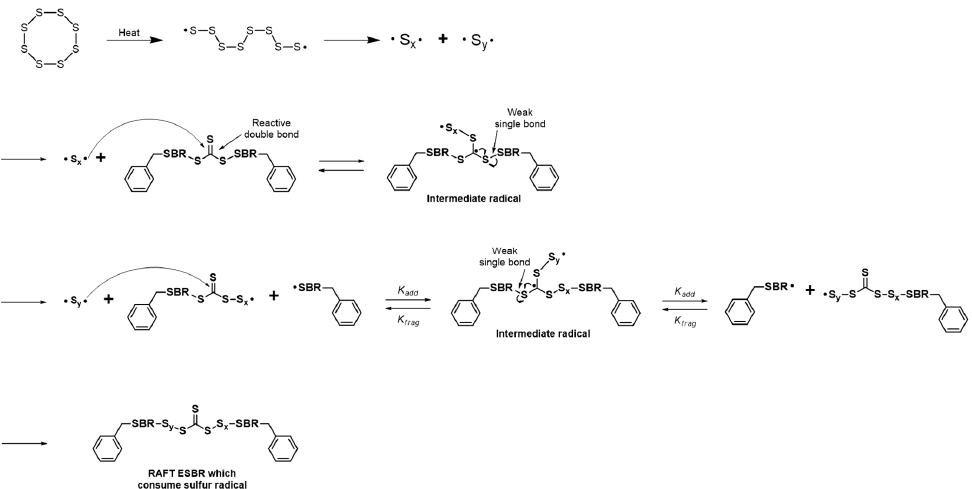
Figure 4. Suggested mechanism of the reaction between reversible addition ‐ fragmentation radical transfer emulsion styrene butadiene rubber (RAFT ESBR) and sulfur.